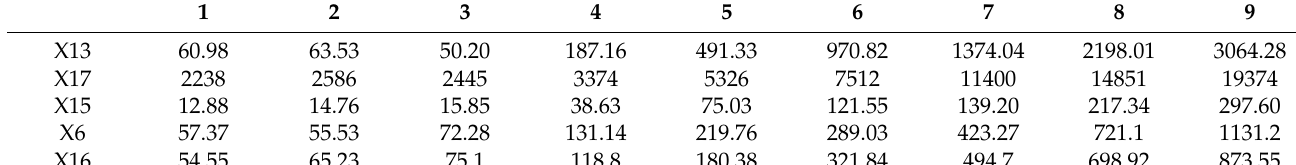
Table 10. Sample Information Table For independent variables.